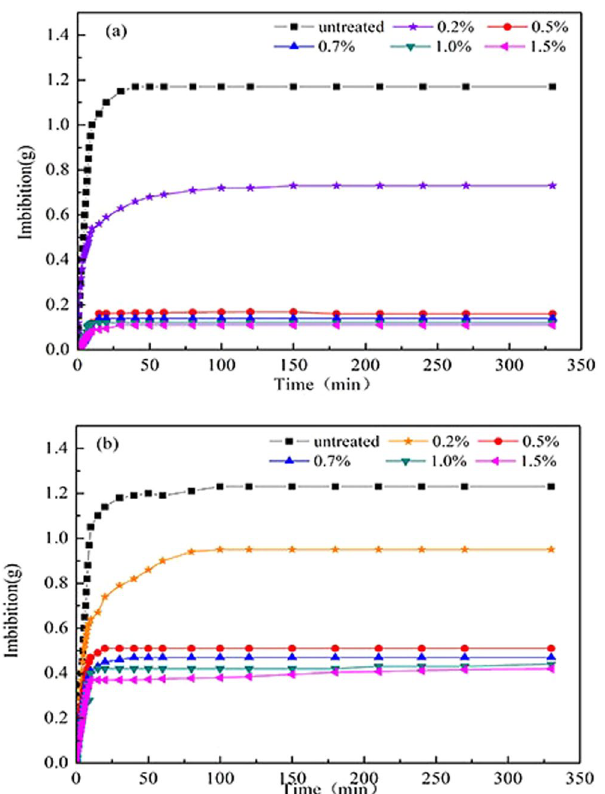
Figure 8. Imbibition of liquid in the shale: ( a ) water; ( b )